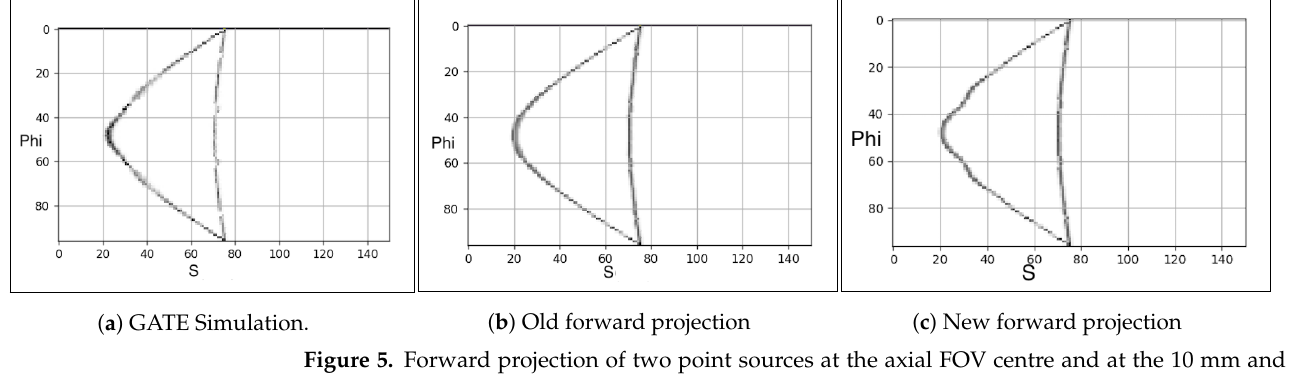
Figure 5. Forward projection of two point sources at the axial FOV centre and at the 10 mm and 100 mm offset from the transaxial FOV centre: GATE ( a ), STIR’s old calculation ( b ), STIR’s new calculation ( c